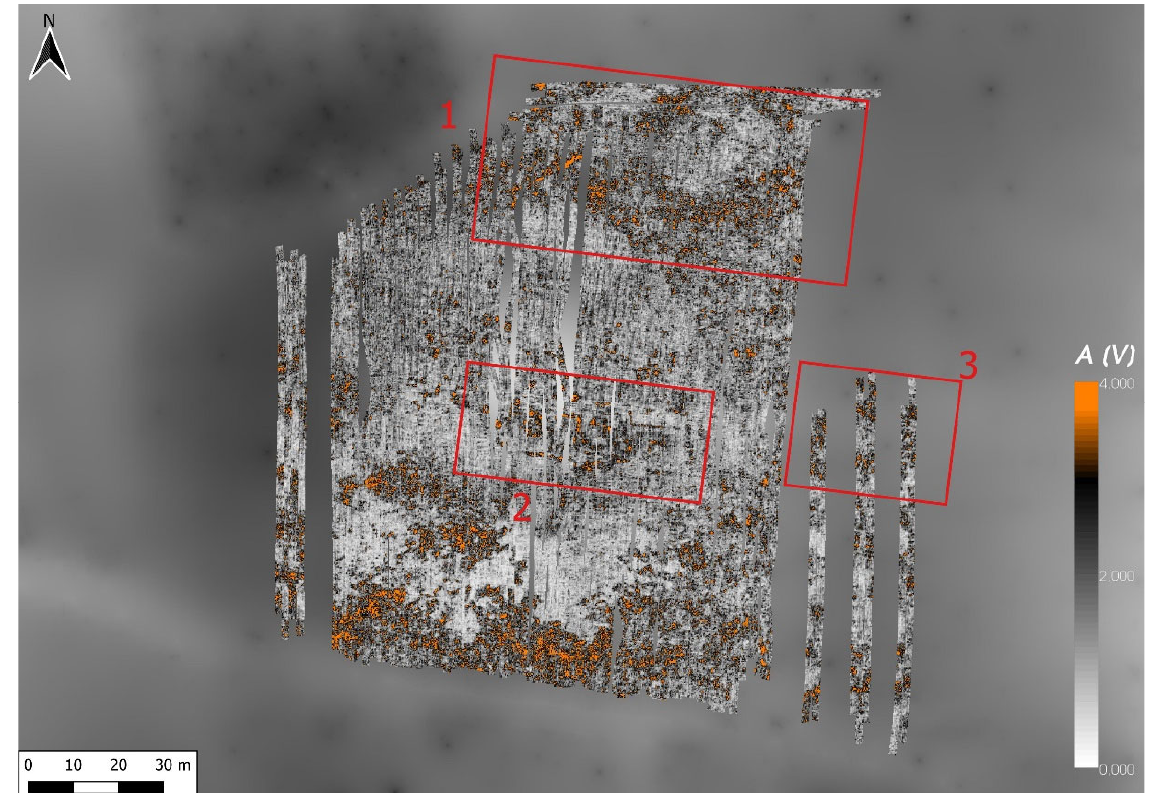
Figure 2. General plan of the projects elaborated with the Stream X georadar at a depth of − 0.5 m below the surface. The white ‐ orange colour scale indicates the resistivity of the signals. The areas with the highest accumulation of archaeological anomalies are marked in red.